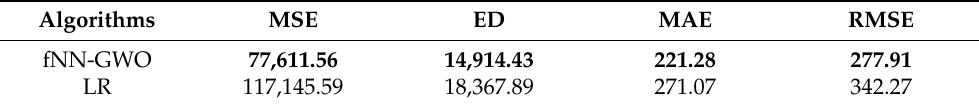
Table 3. A comparison between fNN-GWO error forecasting results for hourly daily load consump- tion, and LR.